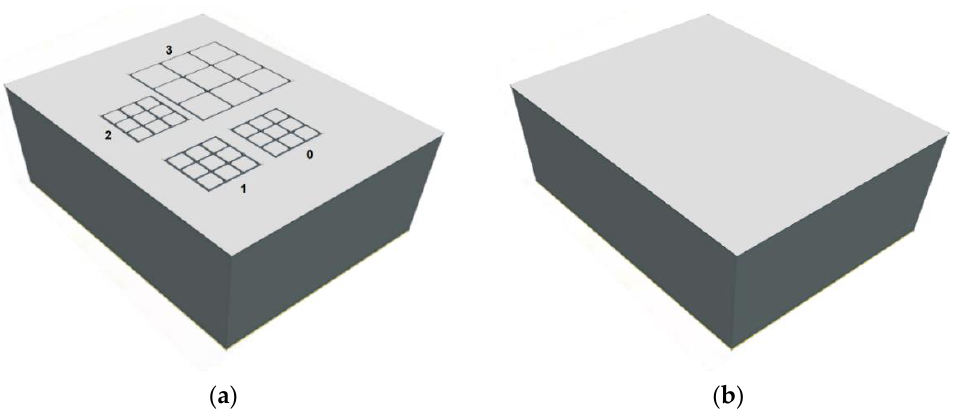
Figure 1. ( a ) The anode layout of the CZT pixel detectors. Array 3 is characterized by a pixel pitch of 500 µm, while the other three arrays by a pixel pitch of 250 µm. The width of the inter-pixel gaps is equal to 50 µm for all arrays. All arrays are surrounded by a guard-ring electrode up to the edge of the crystal. ( b ) The cathode electrode covers the surface of the CZT crystals. The figures are not drawn to scale.